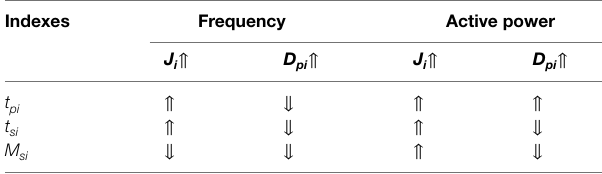
TABLE 1 | Influence of parameter perturbation on dynamic responses. Indexes